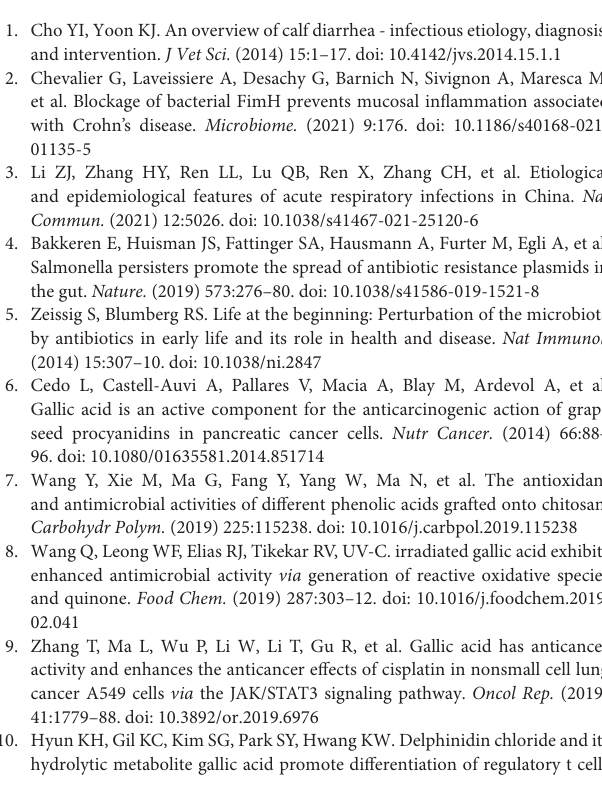
analysis (PCoA) of fecal bacteria based on the weighted UniFrac distance matrix of FMT donors (D) and recipients (E) . The data were assessed using permutational ANOVA (PERMANOVA) analysis with 999 permutations. Supplementary Figure 10 | Colonic short-chain fatty acid (SCFA) levels of neonatal mice donors and recipients. The concentrations of acetate (A) , propionate (B) , and butyrate (C) in donors upon oral GA therapy ( n = 4 per group). Concentrations of acetate (D) , propionate (E) , and butyrate (F) in recipients upon FMT ( n = 6 per group). Data were shown as means ± SEM. Statistical significance was analyzed using unpaired t -test. ∗ p ≤ 0.05, ∗∗ p ≤ 0.01, ∗∗∗ p ≤ 0.001. Supplementary Figure 11 | Spearman correlation between fecal microbiota of FMT recipients and SCFA productions, including acetic acid, propionic acid, and butyric acid. The red color denoted a positive correlation, while blue color denoted a negative correlation. The intensity of the color was proportional to the strength of